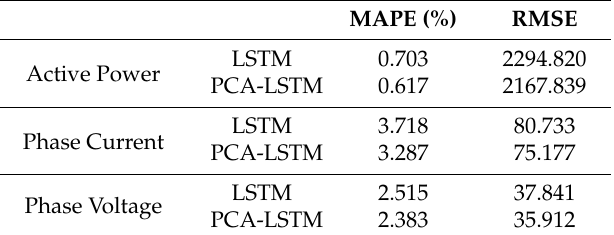
Table 3. Error analysis of forecasting result.